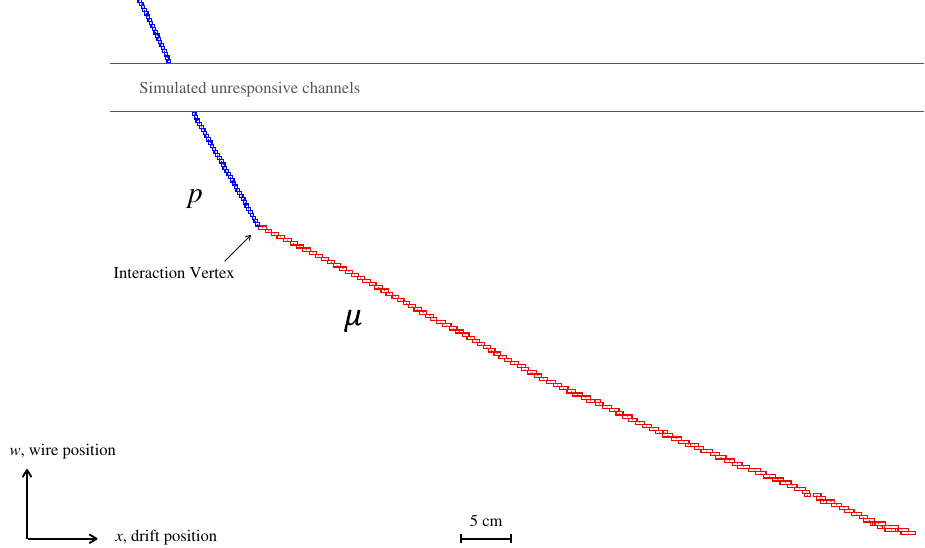
Fig. 11 The reconstruction of a simulated 500-MeV CC ν μ quasi-elastic interaction. The target particles for the reconstruction are the muon and proton. A gap in the reconstructed proton track is observed due to the presence of unresponsive channels, which are included in the simulation